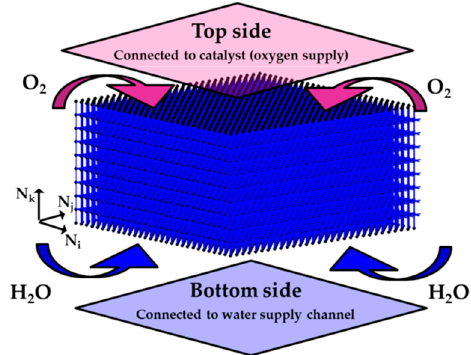
Figure 5. 3D PN under study. Pores are shown in black and throats in blue. The top and bottom pore rows are only vertically connected to their neighbor throats. All pores and throats are initially saturated with liquid.